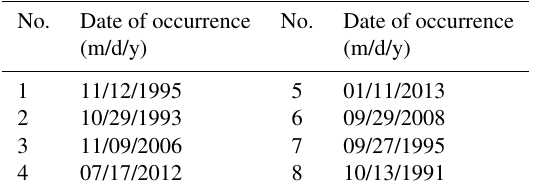
Table 3. Date of 24h duration severe and widespread storms in the study